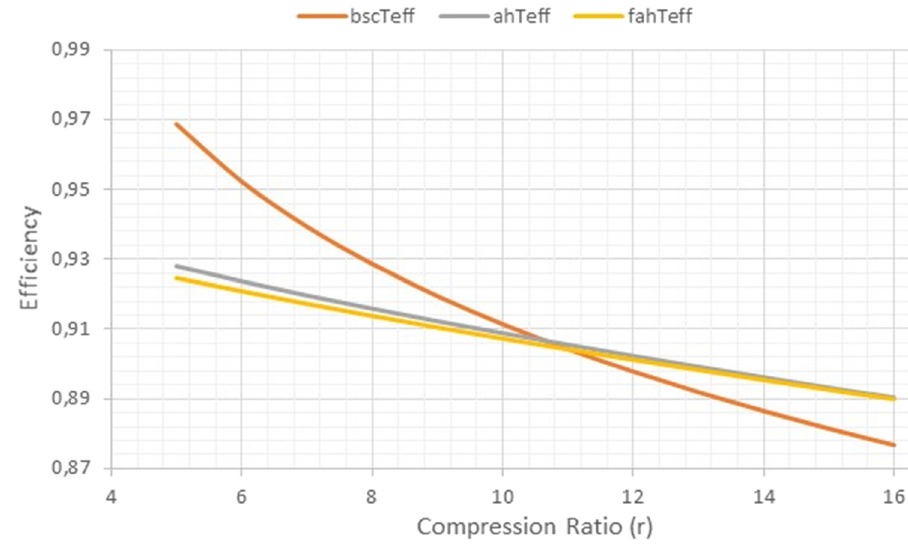
Figure 15: Variation of the turbine e ffi ciency with the compression ratio ( r ) for bsc, ah and fah cogeneration plants.